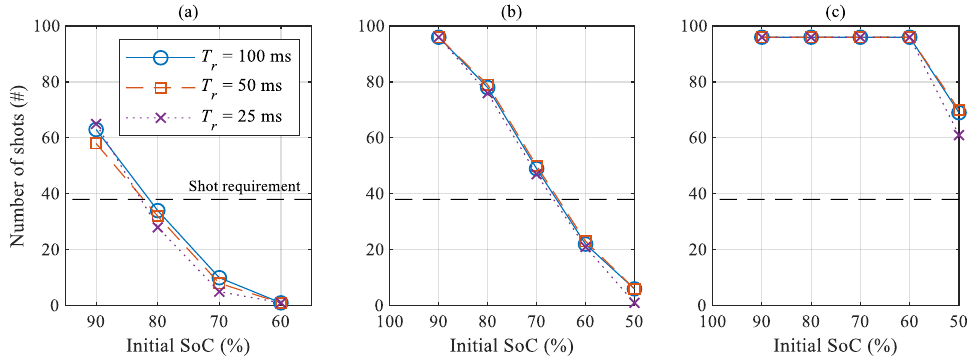
Figure 9. Battery shot performance against pulse rise time and sustained four minute operation target for ( a ) 2 MW ( b ) 1.75 MW and ( c ) 1.5 MW LDEW